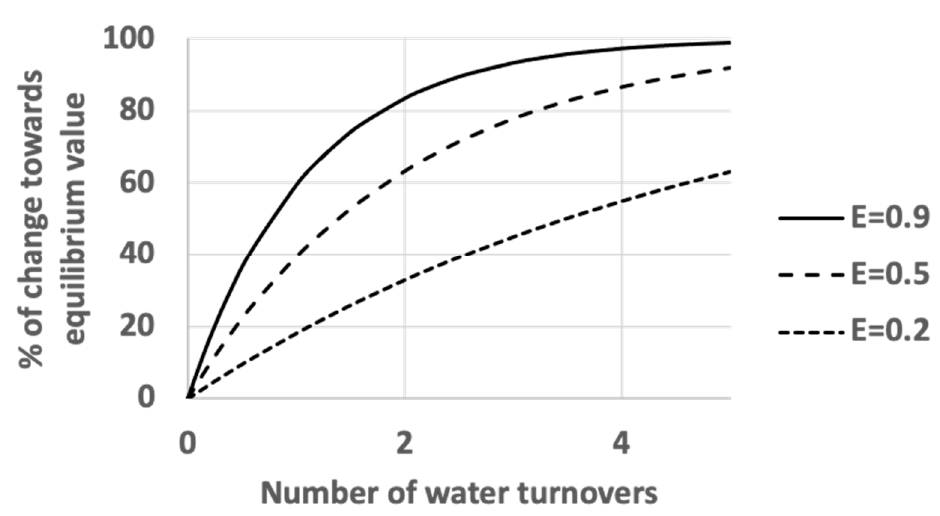
Figure 3. Effect of filtration efficiency (E) on the rate at which turbidity approaches equilibrium following a change in bathing load as the number of water-turnovers increases.